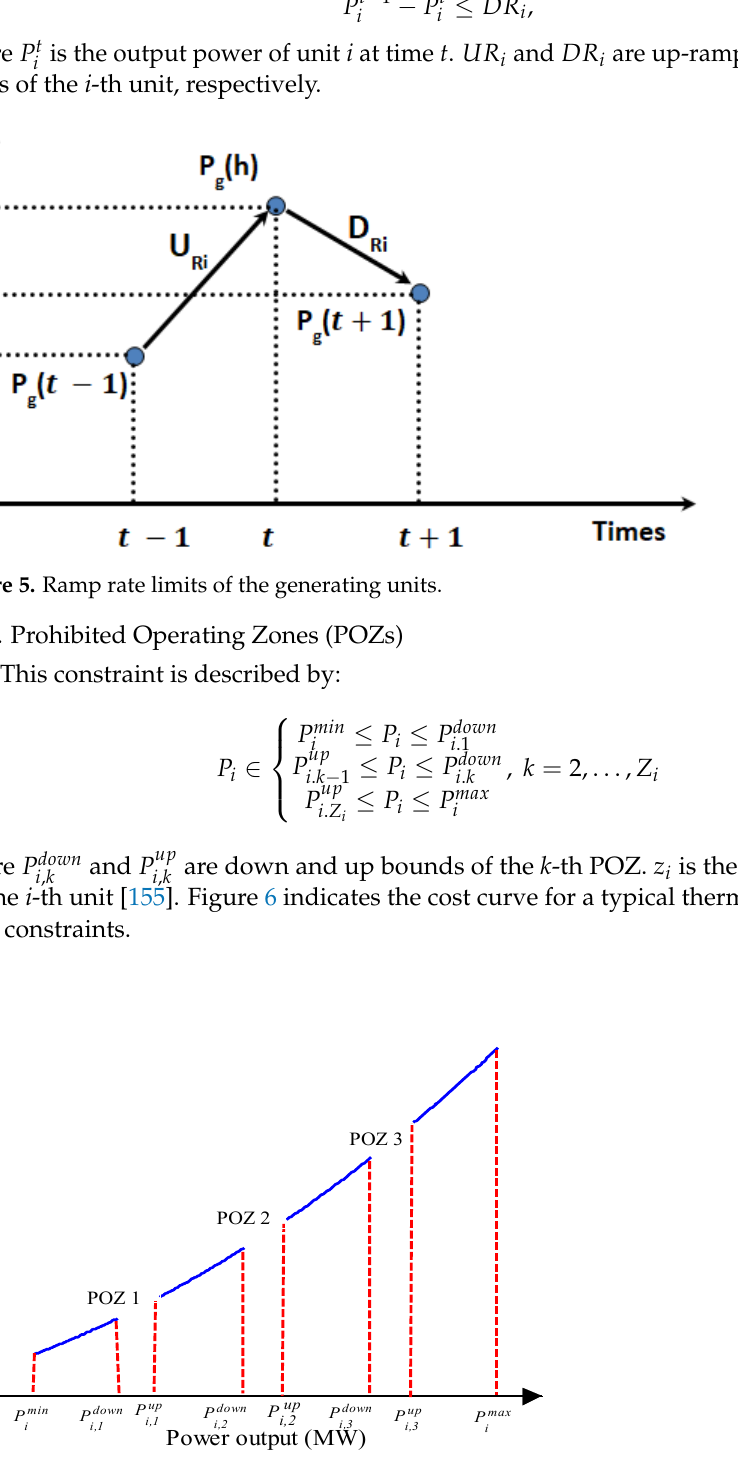
Figure 6. Cost curve for a thermal plant with POZ constraints (blue color represents the discontinuous fuel cost function and red color represents down and up bounds of the POZs).